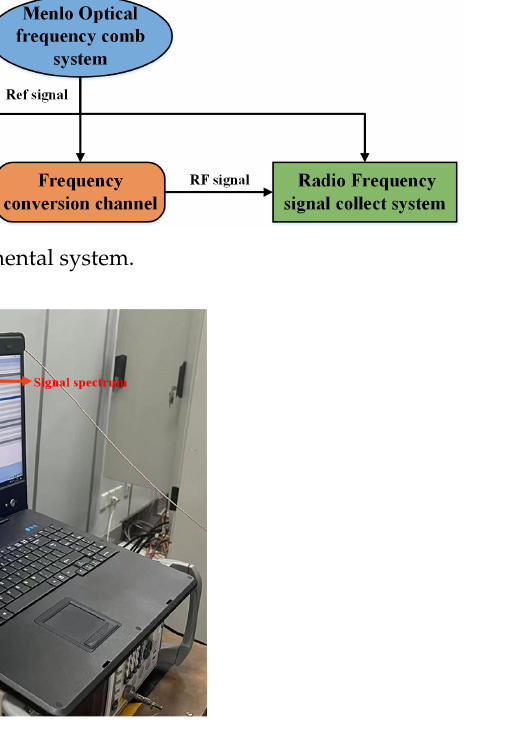
Figure 8. Portable ultra − wideband RF signal high − speed collecting, recording, and playback system (the system needs to connect to the reference clock